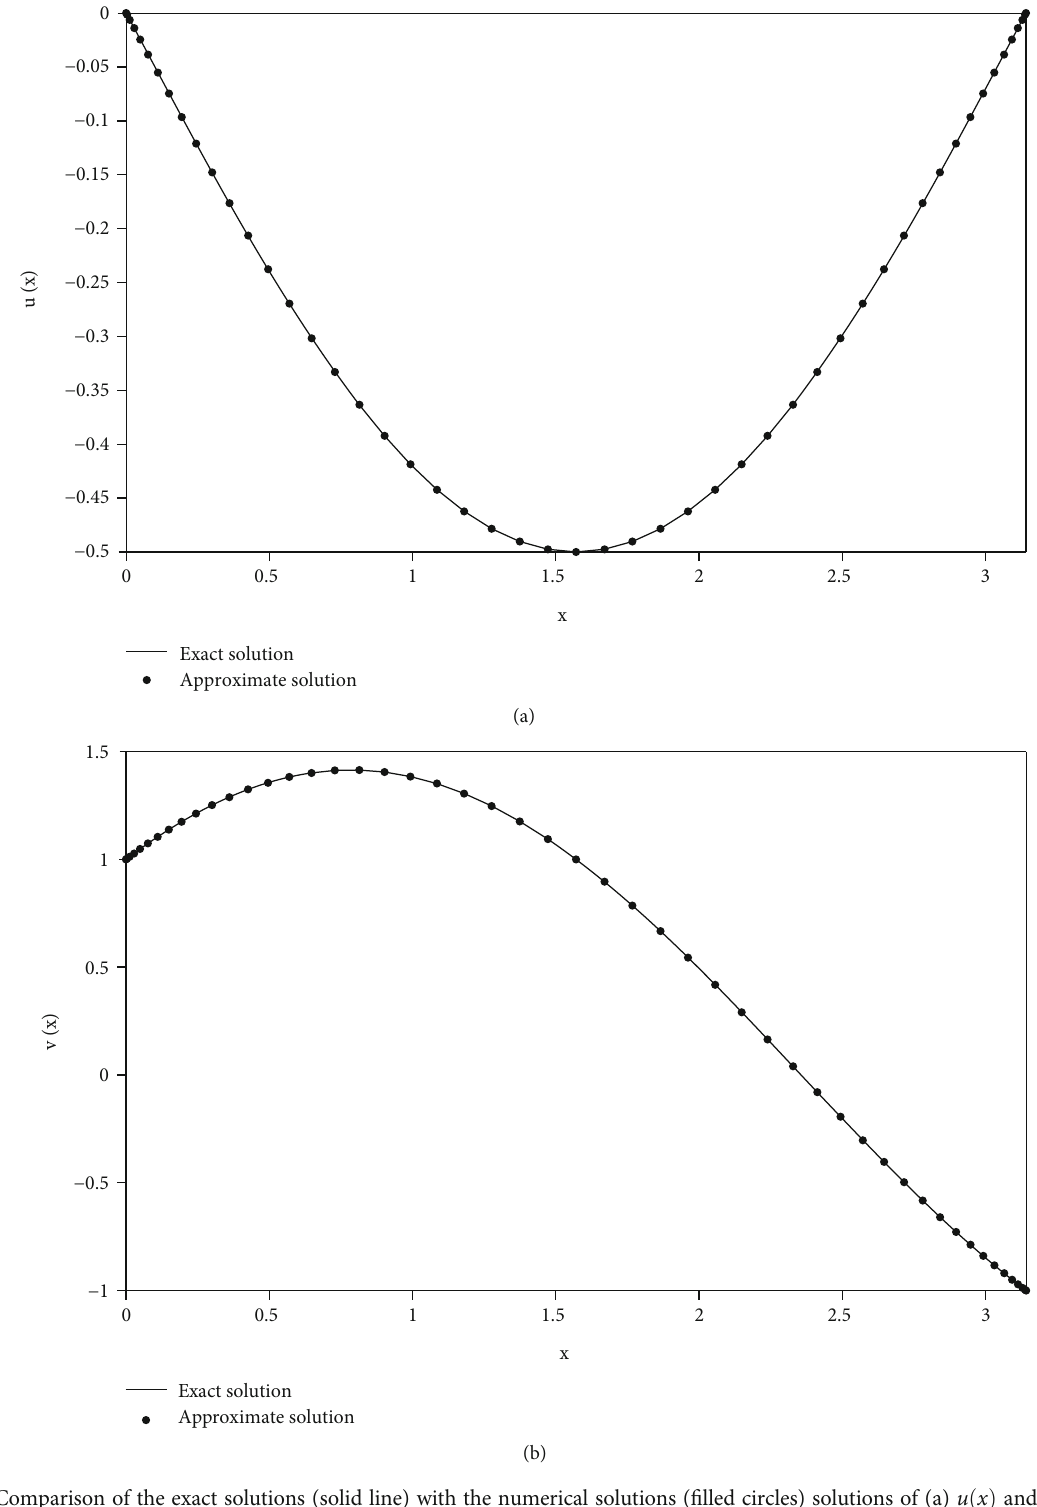
Figure 5: Comparison of the exact solutions (solid line) with the numerical solutions ( fi lled circles) solutions of (a) u ð x Þ and (b) v ð x Þ for Example